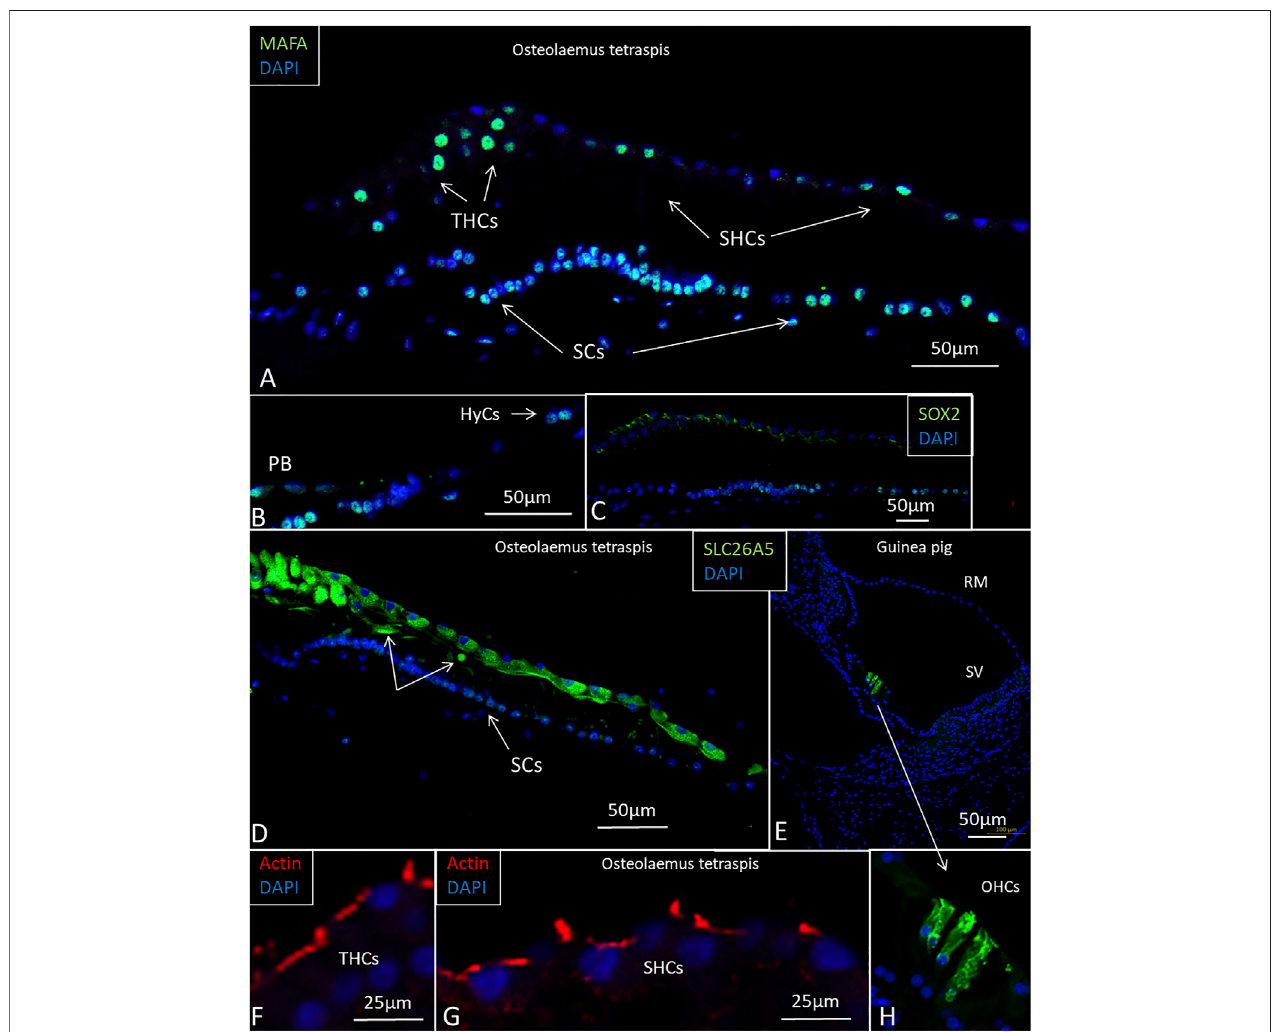
FIGURE 12 | Imuno fl uorescence of the papilla basilaris in the O. tetraspis. (A) . Some THCs and SHCs show strong expression of MAFA. A few THCs have not reached the epithelial surface. Many SC nuclei express the transcription factor MAFA. (B) . Some HyCs express MAFA. (C) . Transcription factor SOX2 is expressed in SCs. (D) . Sensory cells, including the THCs, express SLC26A5/prestin. (E) . Positive control shows SLC26A5/prestin expression in outer hair cells in the guinea pig cochlea. (F) . and (G) . Actin expression in the stereocilia and cuticular plate of the HCs. (H) . Higher magni fi cation of outer hair cells shown in (E) .